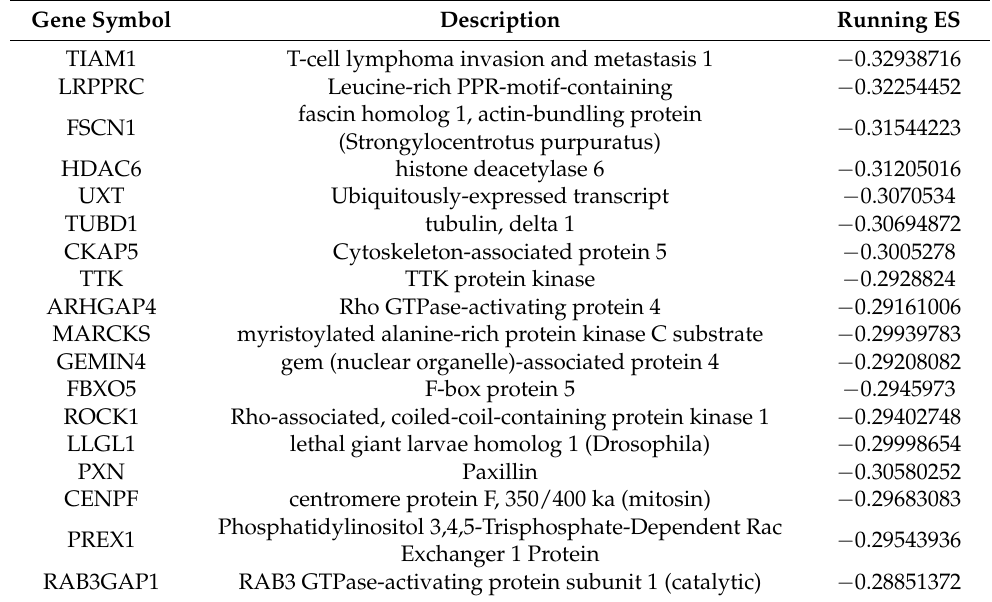
Table 3. Hallmark mitotic-spindle-enriched genes in IMR90 siCENP-E 72 h cells.